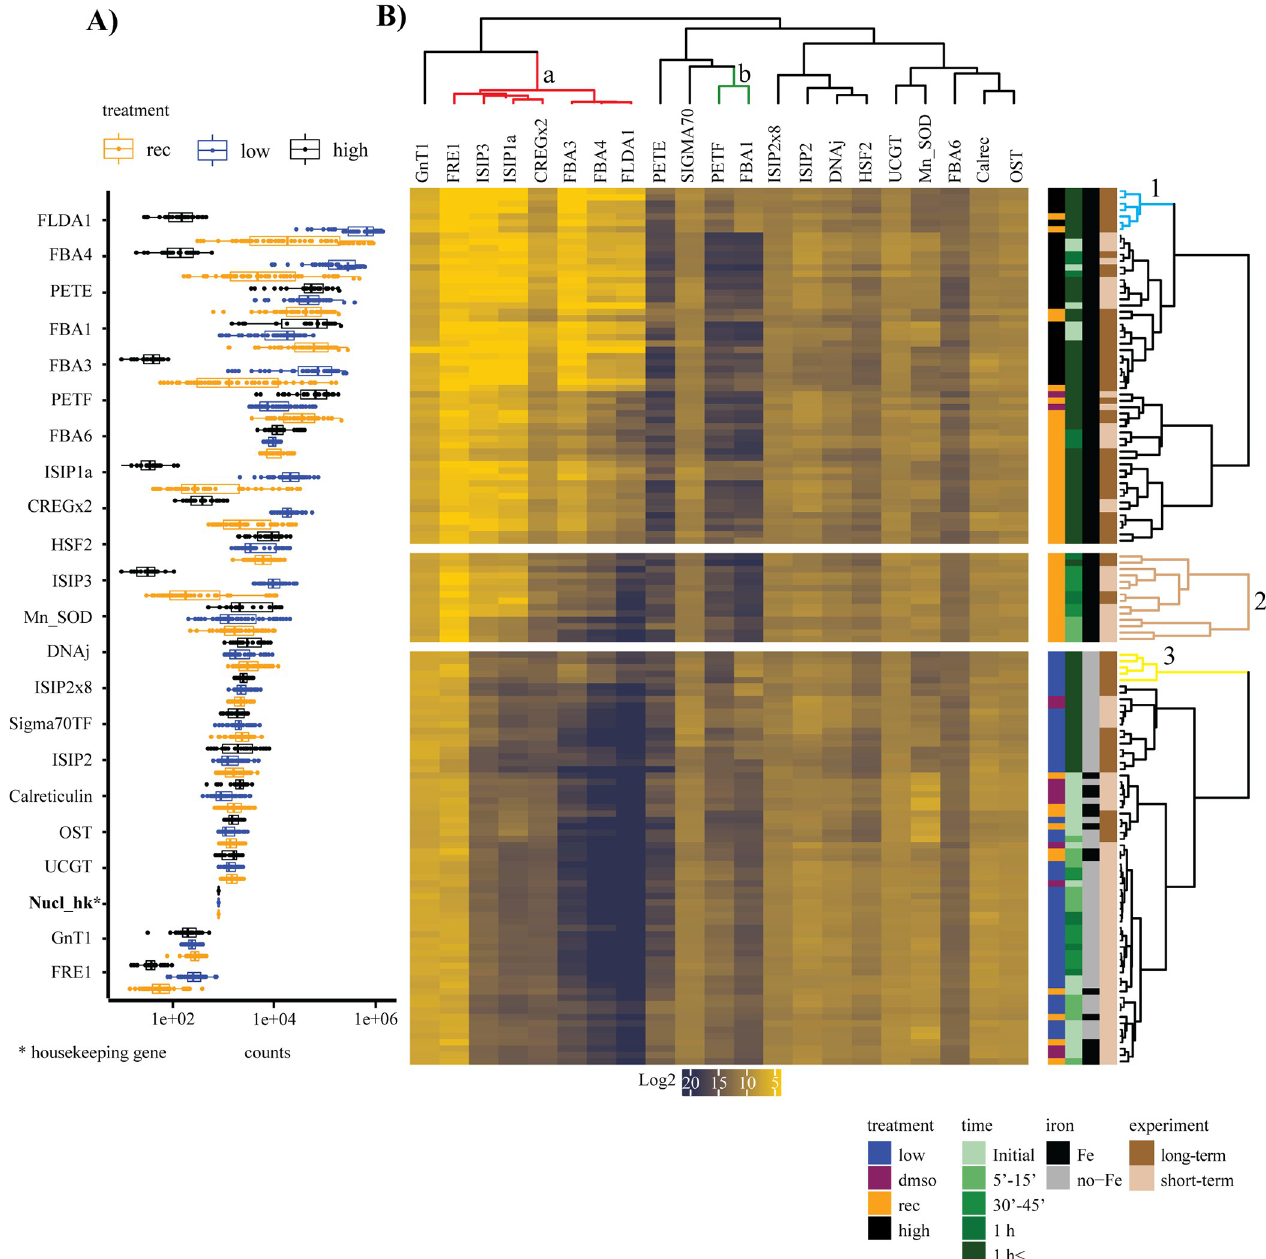
Fig 8. Normalized transcript counts for 21 targeted genes (A) and heatmap of Spearman correlation between transcript levels (B). (A) Normalized transcript counts (counts/100ng of total RNA). Low-iron (blue), high-iron (black), and iron-recovery (rec) (orange) samples are plotted for each gene. The x- axis is plotted in log-scale, with the genes plotted in order of decreasing transcript abundance. (B) Heatmap with clustering based on Spearman correlation. Transcript counts are plotted as log2 values, with yellow and dark blue indicating low and high counts, respectively. The four coloured bars represent treatments, sampling times, iron levels, and experiment type. For the treatment, low-iron samples are shown in blue, dimethyl sulfoxide (DMSO)-treated samples are purple, iron-recovery samples are shown in orange, and high-iron samples are black. Timepoints are separated into Initial, 5–15 min, 30–45 min, 1 h, and > 1 h in increasingly darker shades of green, with darker shades indicating the time progression from earlier to later timepoints. Iron levels are indicated in grey for samples without iron and black for samples with iron. Samples from the long-term experiment are shown in dark brown, and samples from the short-term experiment are shown in light brown. The dendrogram above the heatmap indicates the following clusters: a) downregulated genes following iron addition and b) upregulated genes. The dendrogram on the left indicates clusters 1 and 3 with samples from 12 h and 14 h after iron addition. The split region shown as cluster 2 consists of iron-recovery samples from time points with rapid acclimation of the iron-responsive transcripts. The following abbreviations were used: flavodoxin (FLDA1), fructose-bisphosphate aldolase (FBA), plastocyanin (PETE), ferredoxin (PETF), iron starvation-induced protein (ISIP), cellular repressor of EA1-stimulated genes (CREG), heat shock factor (HSF), manganese-superoxide dismutase (Mn-SOD), transcription factor (TF),